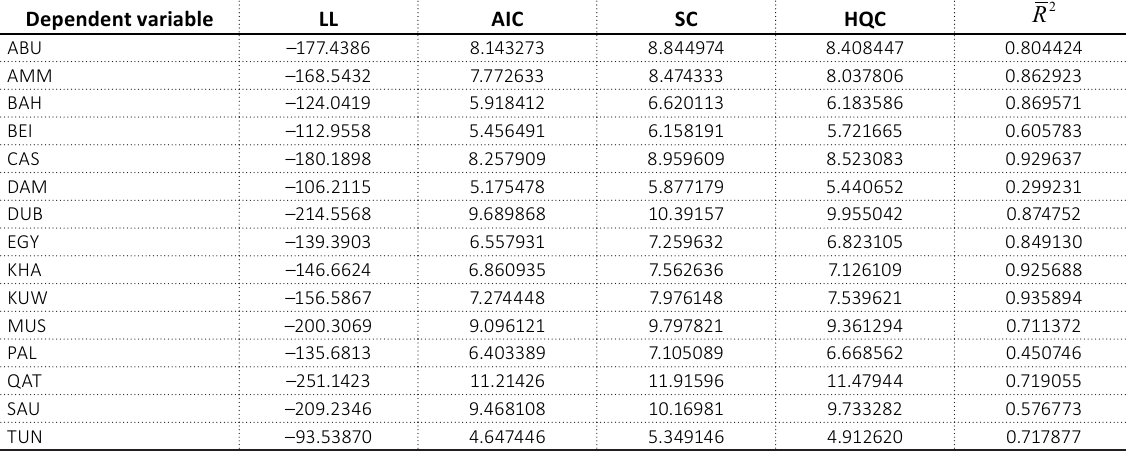
Table 7. Summary results of model estimation, Model 2: EGARCH